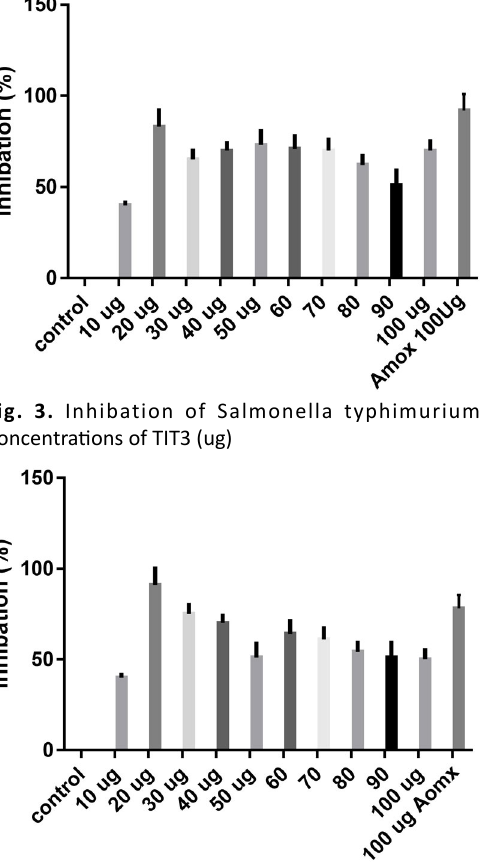
Fig. 5. Inhibation of Klebsiella pneumonia Conentrations of TIT3